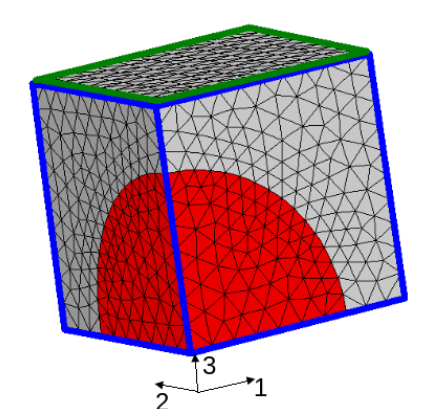
Figure 14. Unit cell used for the 3D finite element micromechanical